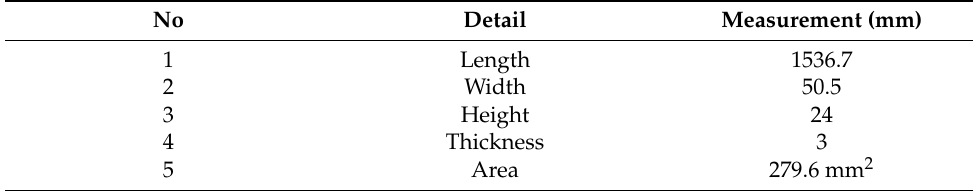
Figure 12. CAD model of the C-section of the longeron. Table 1. Details of the longerons dimension.